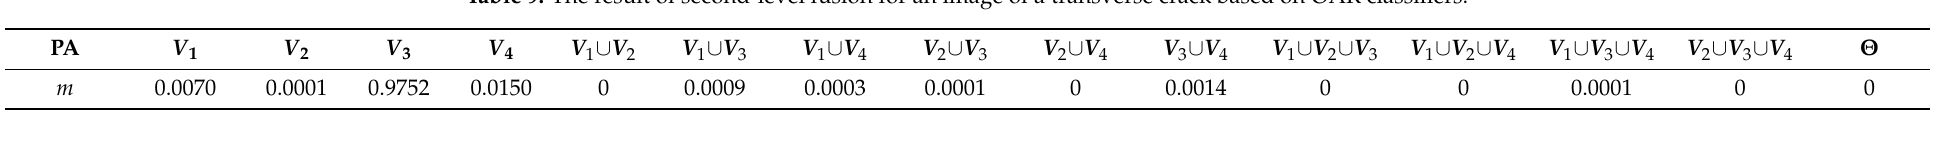
Table 9. The result of second-level fusion for an image of a transverse crack based on OAR classifiers.